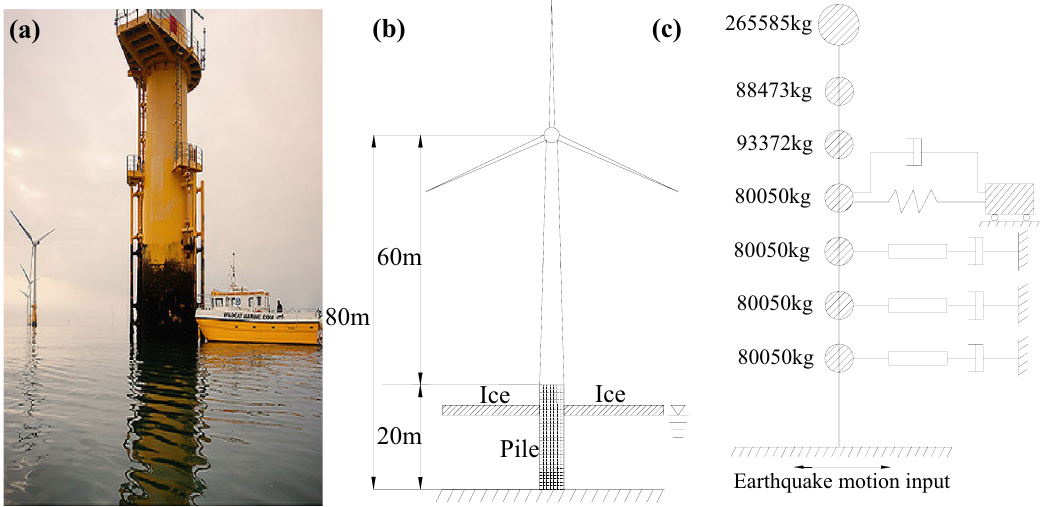
Figure 2. Diagram for a monopole wind turbine tower: ( a ) actual model; ( b ) geometric model; ( c ) simplified model.